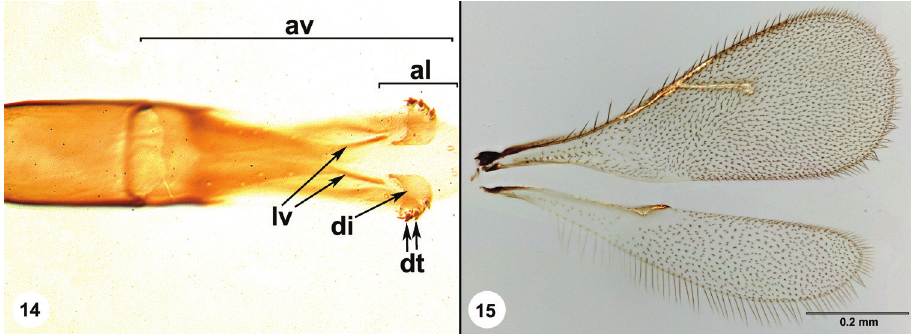
Figures 14–15. Telenomus fariai 14 male genitalia, ventral view 15 female (FSCA 00091164), wings, dorsal view. Annotations. al: aedeagal lob; av: aedeago-volsellar shaft; di: digitus; dt: digital teeth; lv: laminae